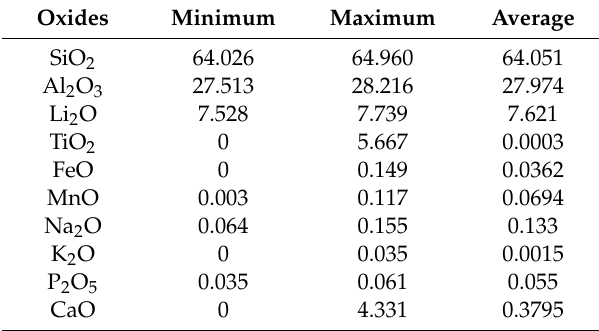
Table 1. Elemental concentration of major elements in wt.% in the kunzite